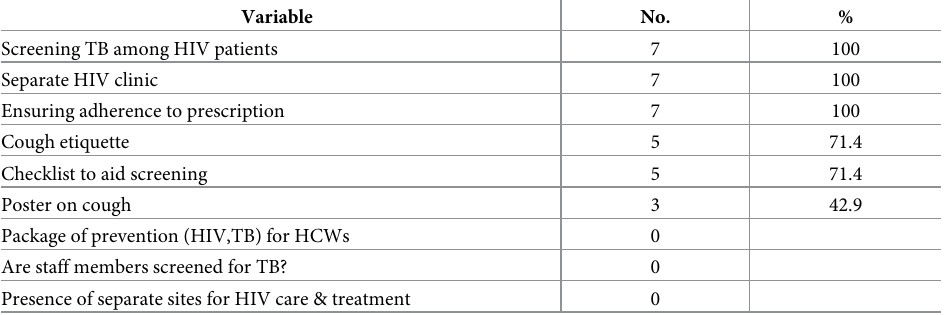
Table 1. The facilities’ clinic organization and presence of other clinical services in Dale district, Sidama Zone, Southern Ethiopia. Variable No. % Screening TB among HIV patients 7